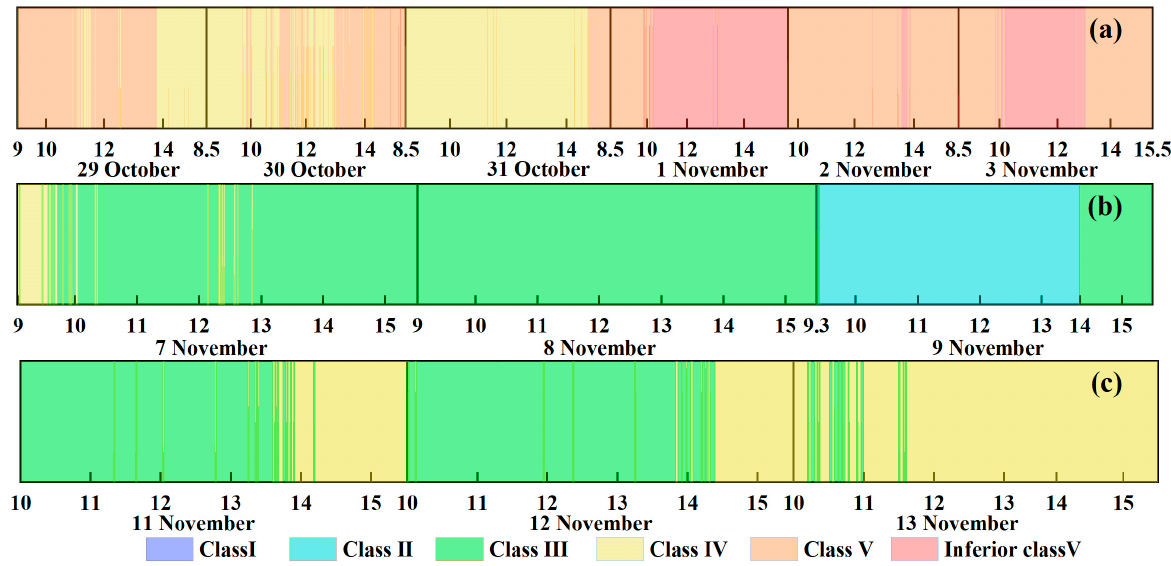
Figure 6. Time series of water body types of Lake Taihu ( a ), Liangxi River ( b ) and Fuchunjiang Reservoir ( c ) based on total phosphorus concentration assessment from 9:00 to 15:30 during 29 October to 13 November 2020.